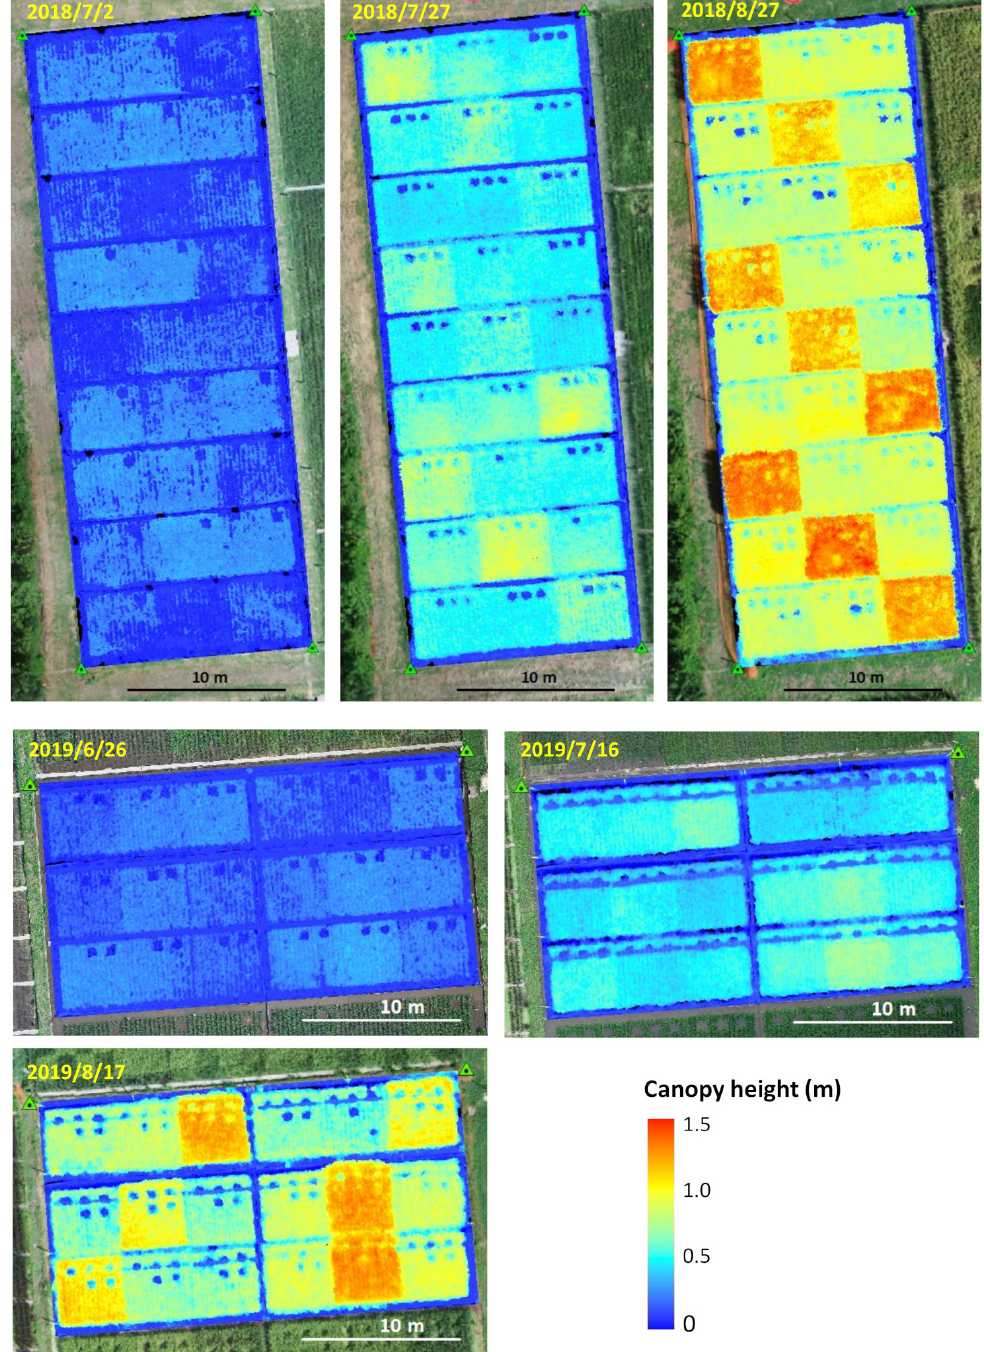
Figure 6. Examples of canopy surface model (CSM) for three rice cultivars in two vegetation